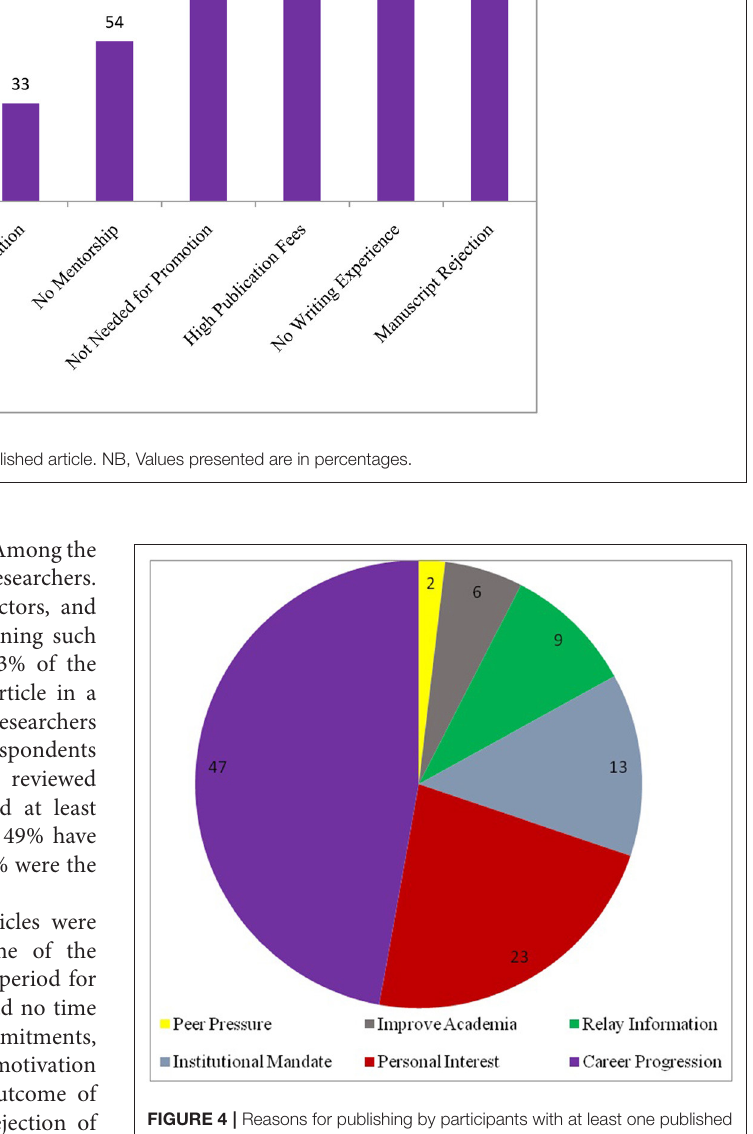
FIGURE 4 | Reasons for publishing by participants with at least one published article. NB, Values presented are in